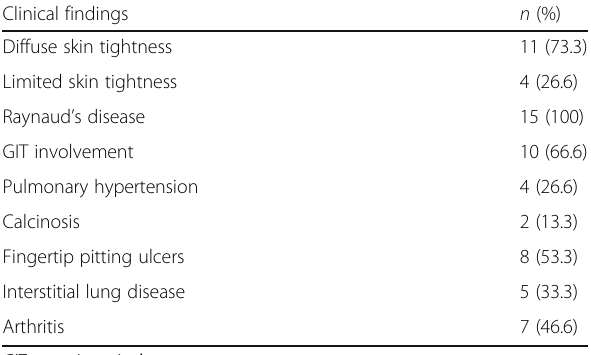
Table 1 Systemic sclerosis patients ’ clinical data Clinical findings